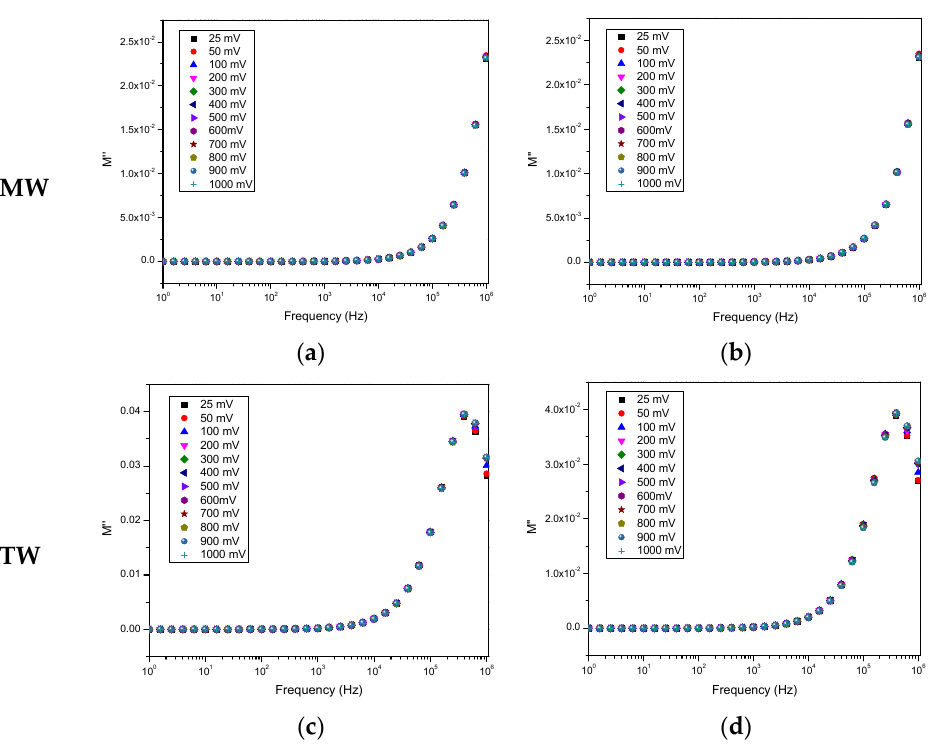
Figure 4. Spectra of the imaginary component of the electrical modulus (M’’) of the sensor devices, when immersed in water solutions with a concentration of 10 − 12 M of EE2, for a range of applied voltages: ( a ) uncoated IDE in MW, ( b ) IDE coated with (PEI/PSS) 5 film in MW, ( c ) uncoated IDE in TW, ( d ) IDE coated with (PEI/PSS) 5 in TW. The relative error is less than 1%.